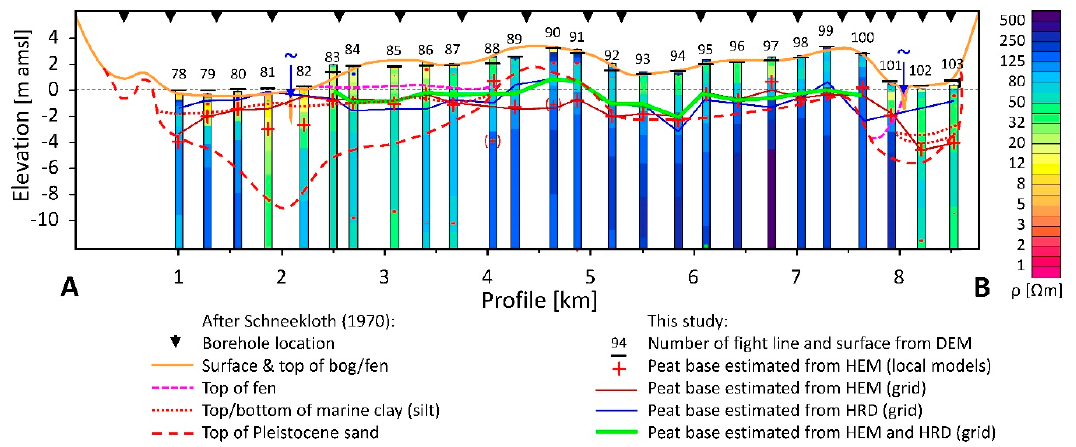
Figure 20. 1D HEM inversion models and comparison of peat base elevations derived by Schneekloth [16] and airborne geophysics along profile A–B (see Figure